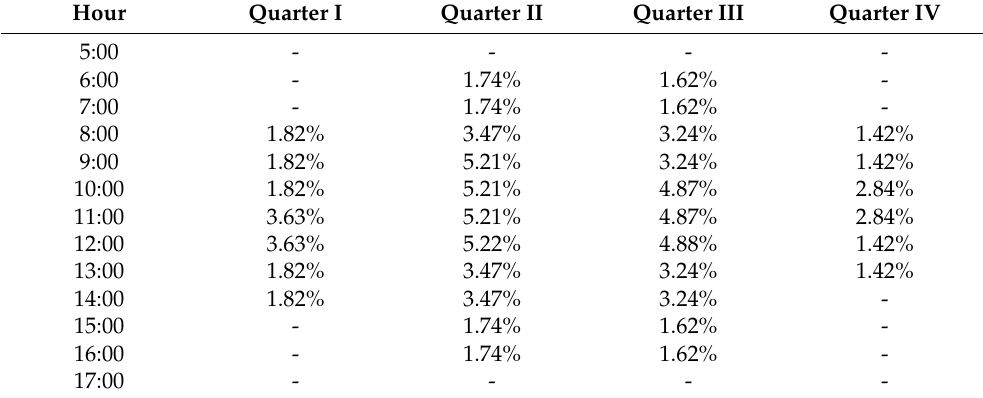
Table 5. Hourly profile of production of energy from the micro-installation on a percentage basis.